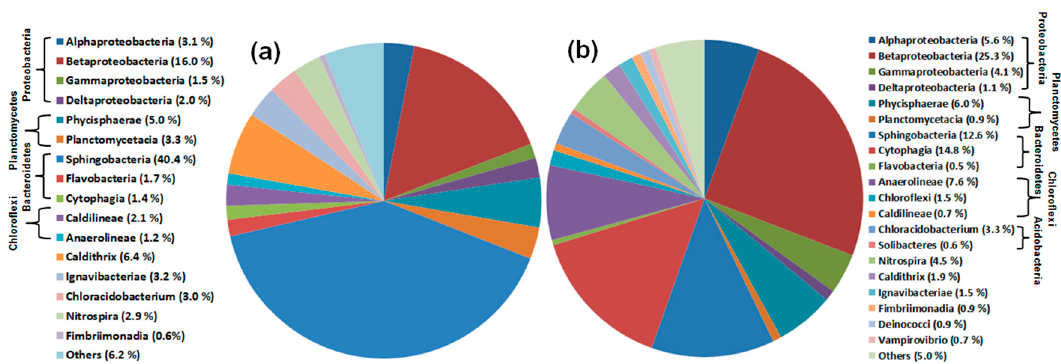
Figure 5. Taxonomic classification of pyrosequences at class levels. Minor classes accounting for <0.5% of total sequences are grouped as “others”. ( a ) Mixed liquor from the DWW; and ( b ) mixed liquor from the HWW.